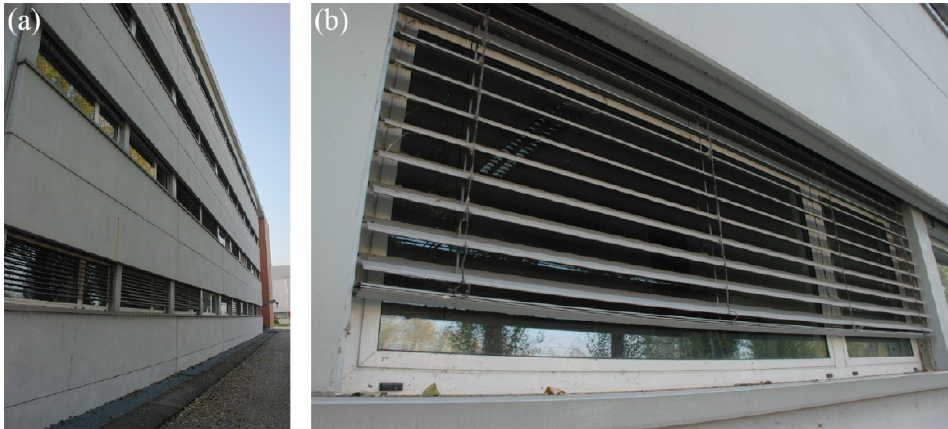
Figure 1. ( a ) Building view; ( b ) Shading louvers installed over a